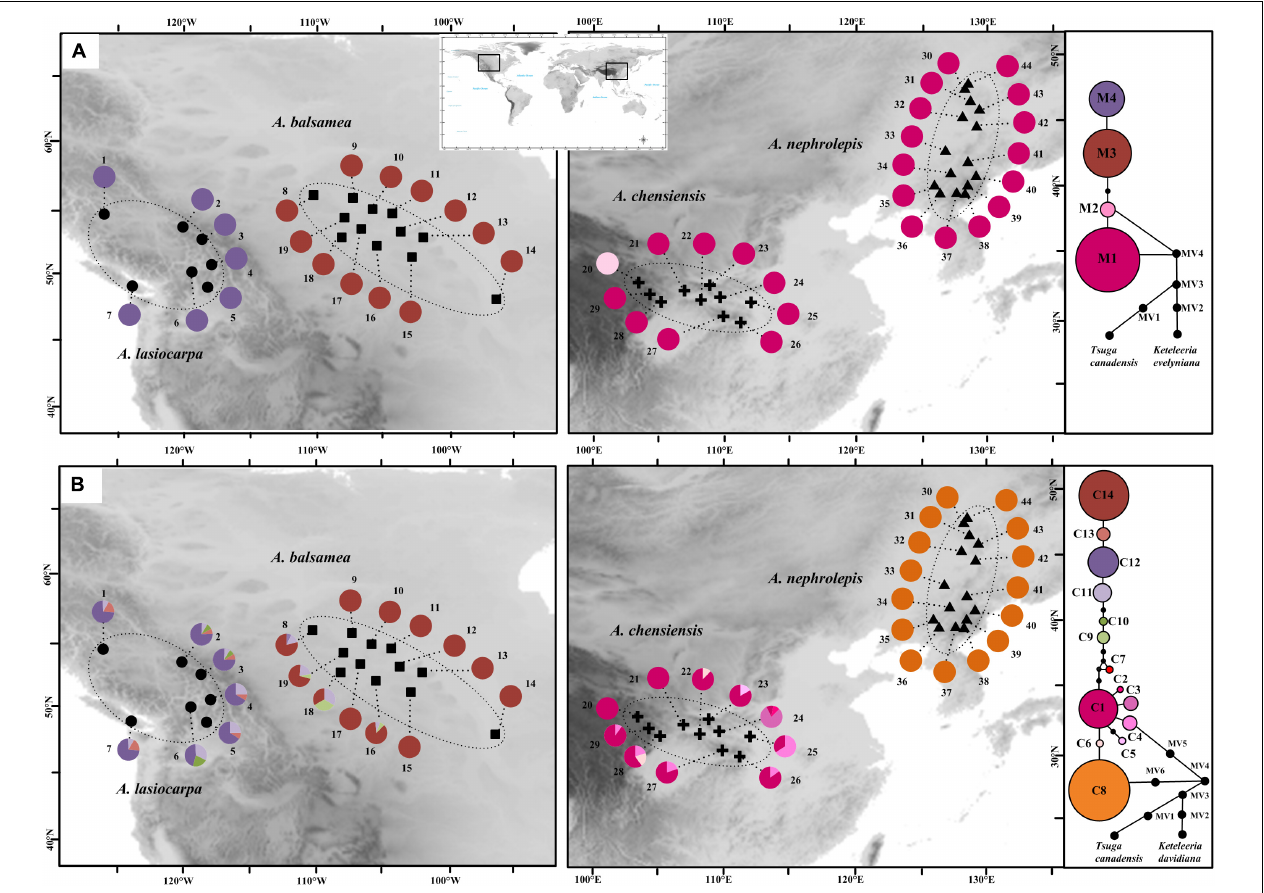
FIGURE 3 | Geographic distribution and network relationships of mtDNA genotypes (A) and cpDNA genotypes (B)